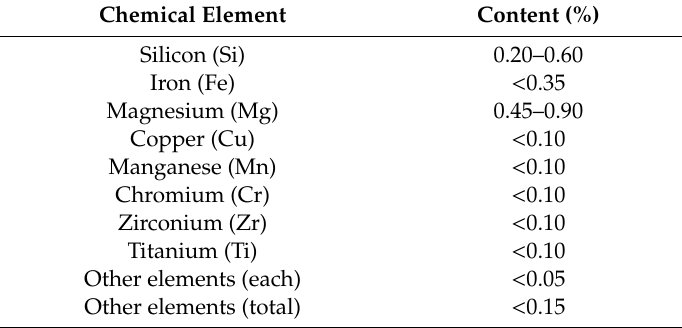
Table 1. Chemical composition of 6063 aluminum alloy in international standards.